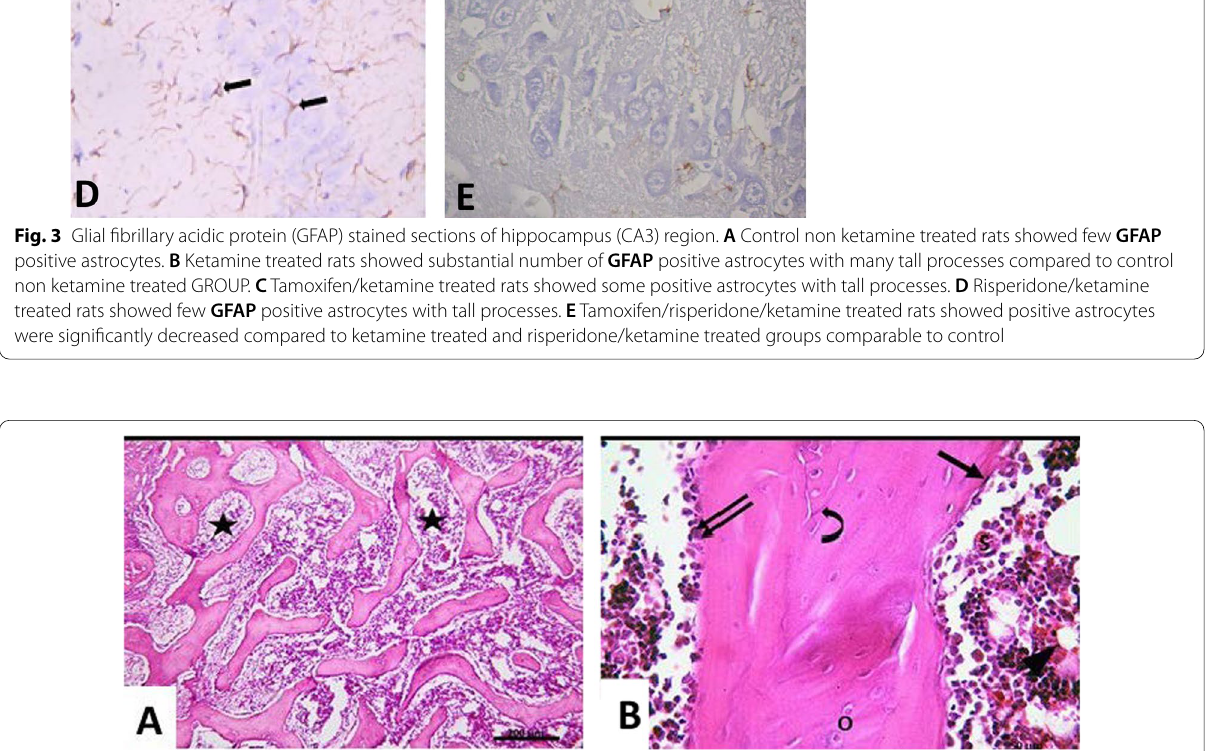
100). Bone trabeculae were covered with endosteum ×